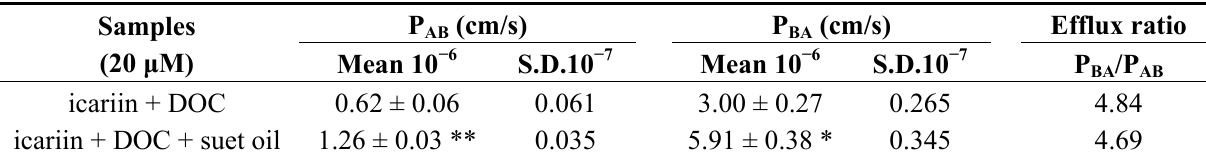
Table 2. Permeabilities (P) and efflux ratios of the self-assembled nanomicelles ( x ± S.D., n = 3). Samples